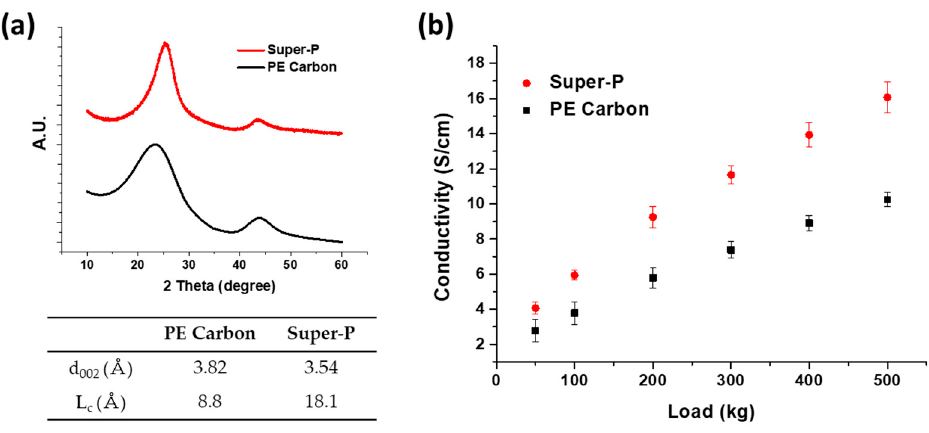
Figure 5. ( a ) XRD results and ( b ) electrical conductivity of carbon nanoparticle for PE and Super-P.